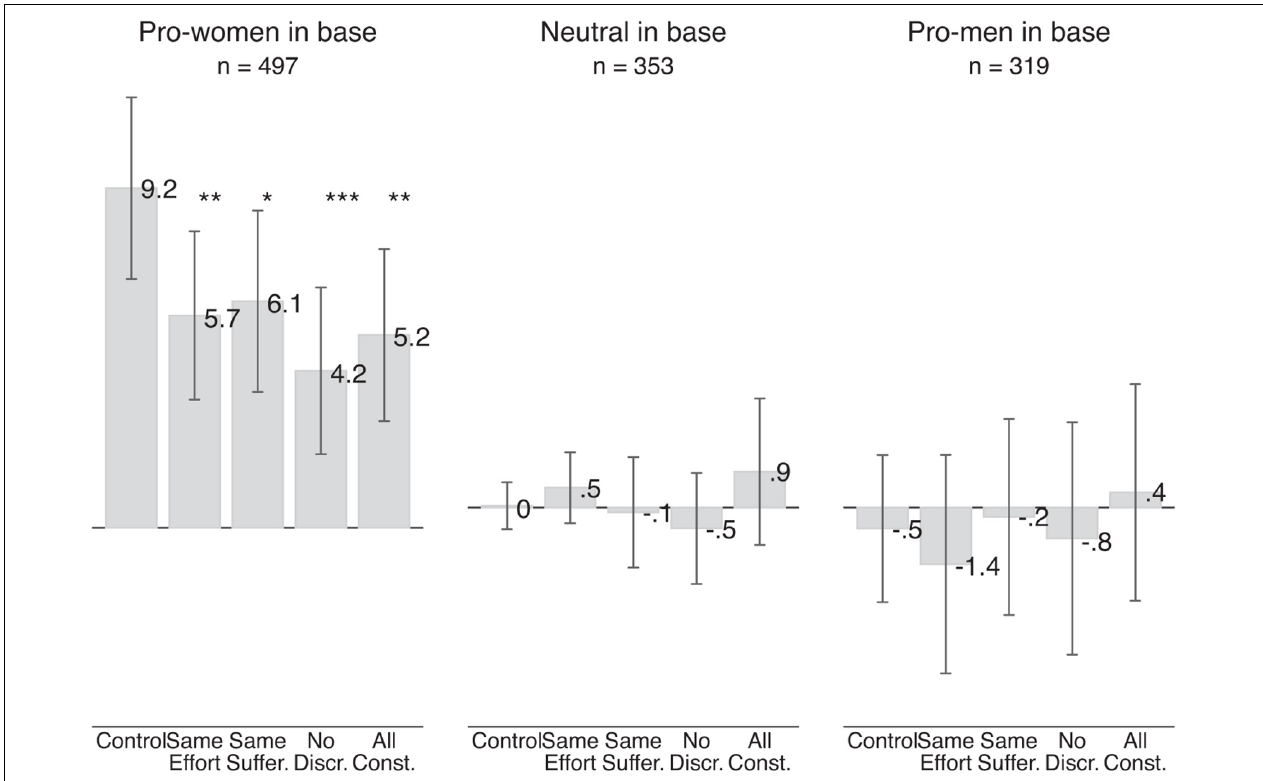
FIGURE 8 | Effect of information treatments on pro-women attitude (Mturk sample). The gray bars show the average pro-women attitude in a given treatment. Each bar in the control group shows the average pro-women attitude for pro-women, neutral and pro-men respondents, respectively. The left-most bar is based on 2,144 judgments made by 268 respondents who were pro-women in the base scenarios and were randomly assigned to the control group, judging four pairs of scenarios involving two judgments each. Each of the next four bars is based on 458 judgments made by 229 respondents who were pro-women in the base scenarios and were randomly assigned to any of the three treatment groups. Similarly, the left-most bar in the middle section is based on 340 judgments by 170 respondents who were neutral in the base scenario, and each of the next four bars is based on 366 judgments made by 183 respondents. The left-most bar in the right-most section is based on 340 judgments made by 170 respondents who were pro-men in the base scenario, and the next four are based on 298 judgments by 149 respondents. Vertical lines show 95 percent confidence intervals based on standard errors clustered at the individual level. Statistical significance of the difference between control group and scenarios with different information treatments is denoted by *** p -value < 0.01, ** p -value < 0.05, and * p -value <